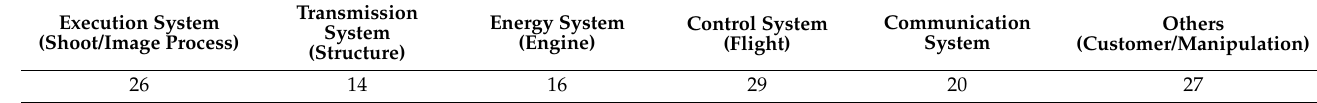
Figure 14. IPC network. Table 4. Degree of centrality of the six R&D themes’ nodes in the IPC network.